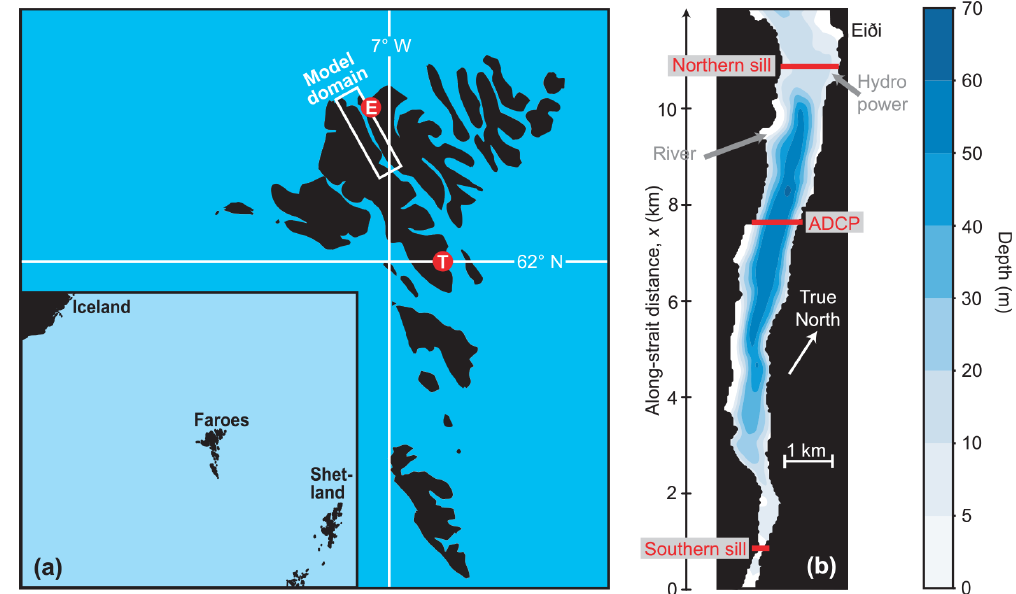
Figure 1. (a) The strait studied in this paper is located within the white rectangle, which defines the domain of a high-resolution model used in the study. The Faroes are situated between Iceland and Shetland (inset map). The red circles show two sites: Tórshavn (T) (pronounced: ) and Eiði (E) (pronounced: ) referred to in the text. (b) Bottom topography of the strait. Freshwater supply from a river and a hydropower plant are shown by grey arrows. Red lines indicate three cross-strait sections discussed in the paper. The vertical x axis indicates along-strait